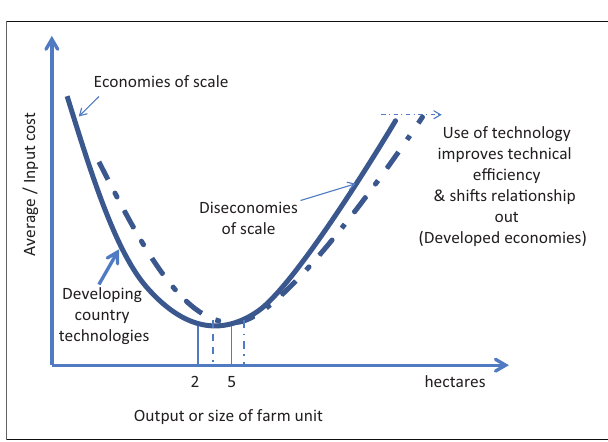
FIGURE 1-A1: Economies and diseconomies of